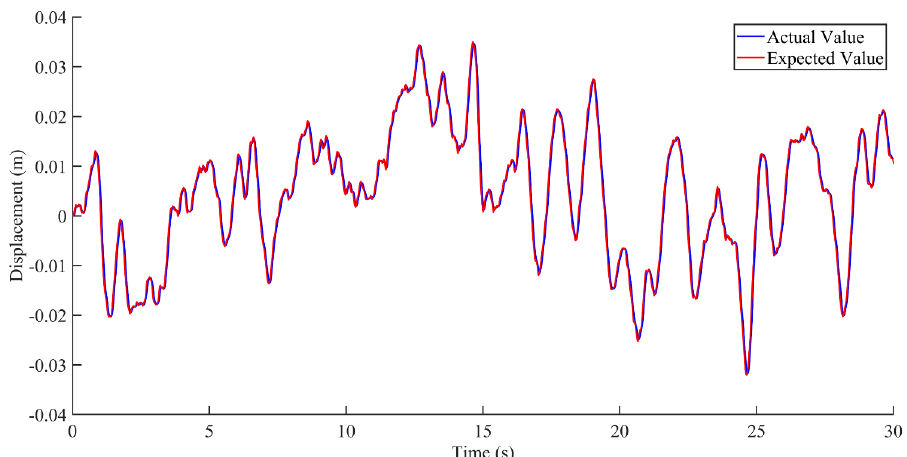
Figure 12. Comparison between actual value and expected value of vibration displacement based on state feedback control under the condition of no interference.